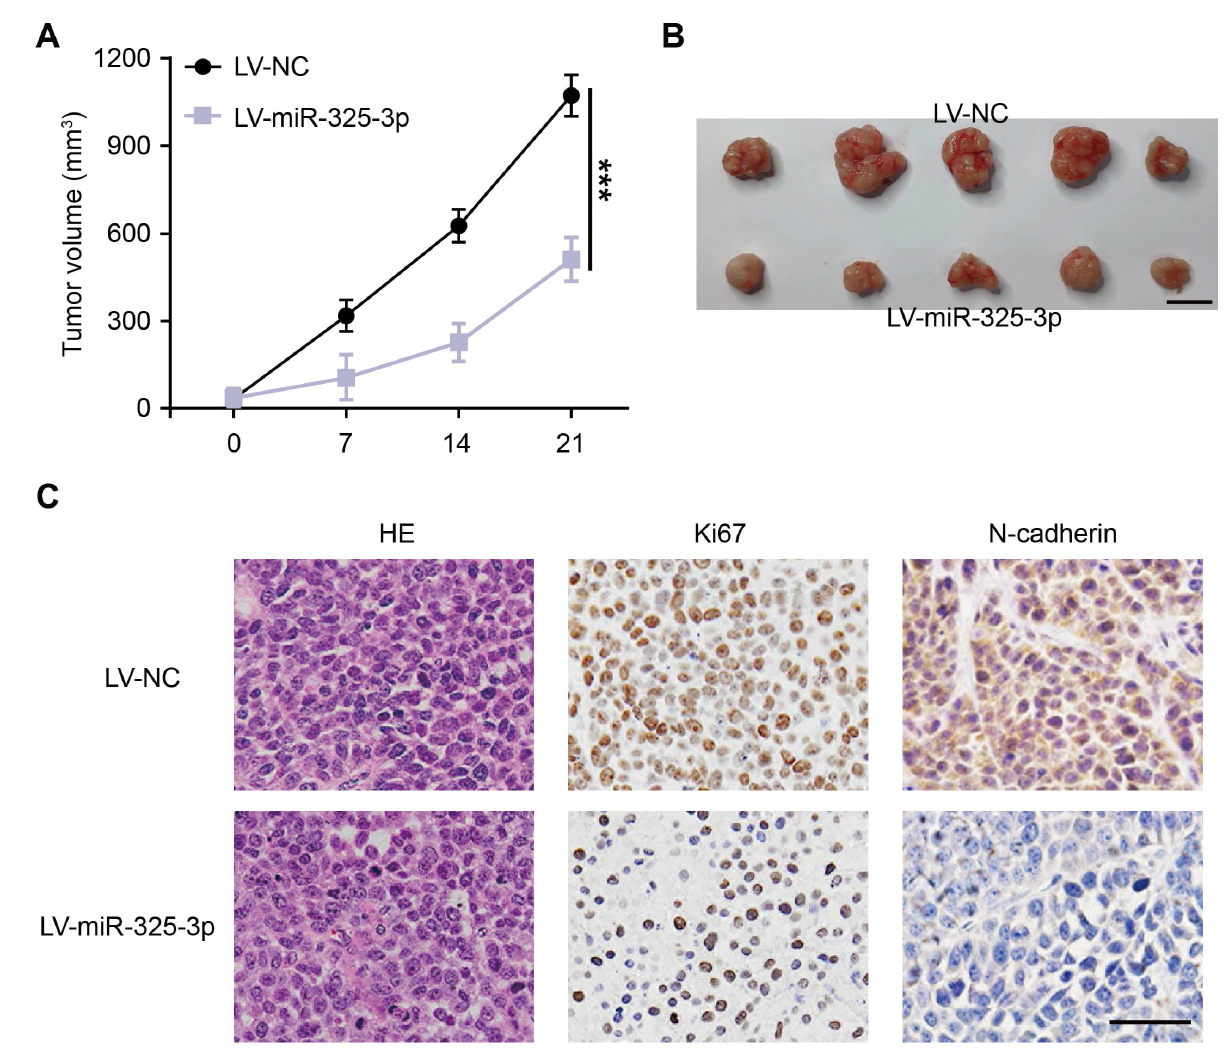
Fig. 7. MiR-325-3p repressed glioma growth in vivo. (A) Tumor volumes from the U87 cell xenograft model from the miR-325-3p-overexpressing group were significantly reduced. (B) Representative tumor images from the xenograft mice. (C) As indicated, representative H&E staining and IHC images of Ki67 and N -cadherin in subcutaneous xenografts derived from cells. Scale bar: 100 µ m. Data are presented as the mean ± SEM, *** p < 0.001, compared to the LV-NC